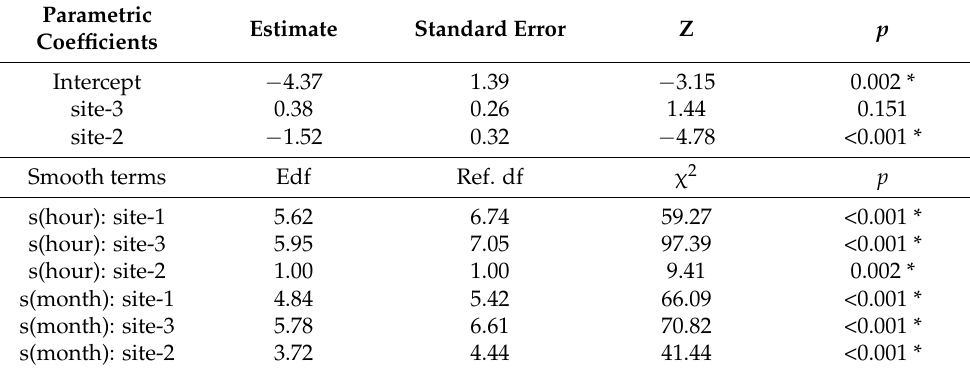
Table 3. The table below summarizes a negative binomial GAM model used to examine the effect of recording time and month on C. poliocephalus ’s activity. The recording hour and month were modeled independently with smoothed function for each monitored site, while the cyclic predictor was modeled using a cyclic cubic regression spline. Reference degrees of freedom was used to calculate test statistics and p -values are represented by Ref. df, whereas Edf (Effective degrees of freedom) indicates the curviness of the